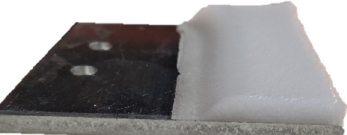
Table 1. Summary table of the icing test conditions. Condition 1 generates glaze ice, and condition 2 generates rime